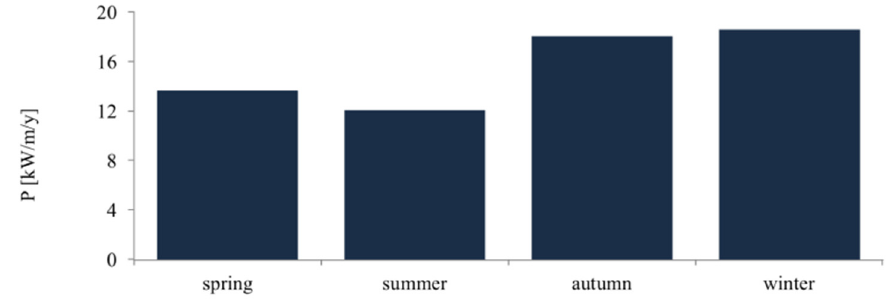
Figure 8. Seasonal distribution of the wave energy flux, averaged over 10 years at point P16.